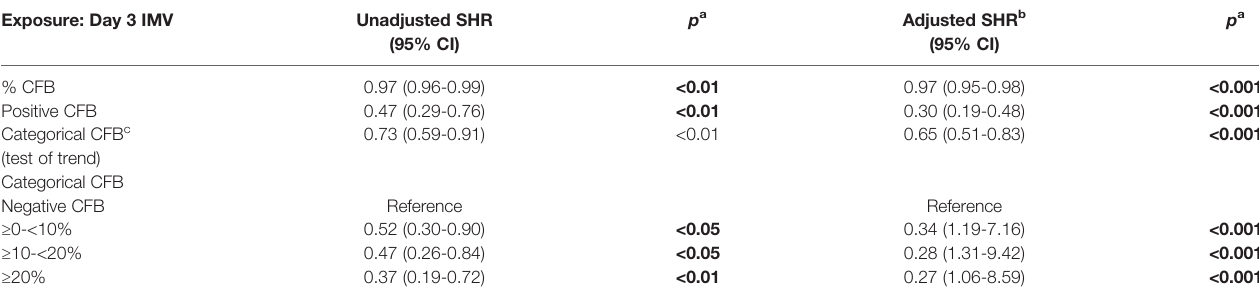
TABLE 4 | Association between day 3 cumulative fl uid balance and rate of extubation (60 days). Exposure: Day 3 IMV